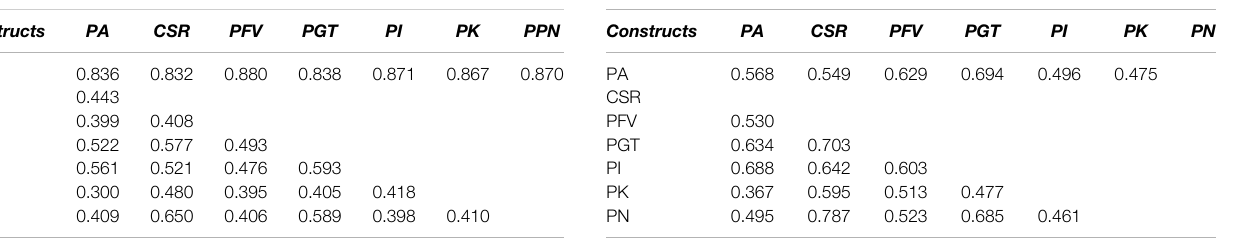
TABLE 2 | Fornell-larcker